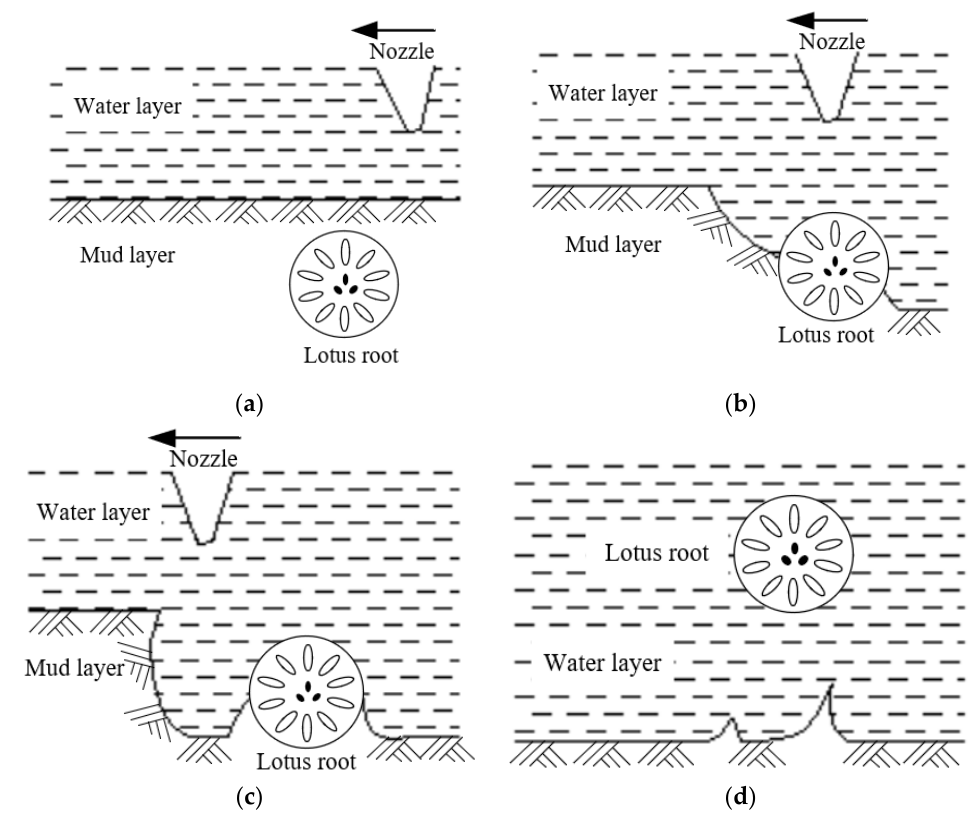
Figure 1. Floating process of a lotus root. ( a ) Initial state of the lotus root; ( b ) Start of floating; ( c ) Continuous floating; ( d ) Total floating.